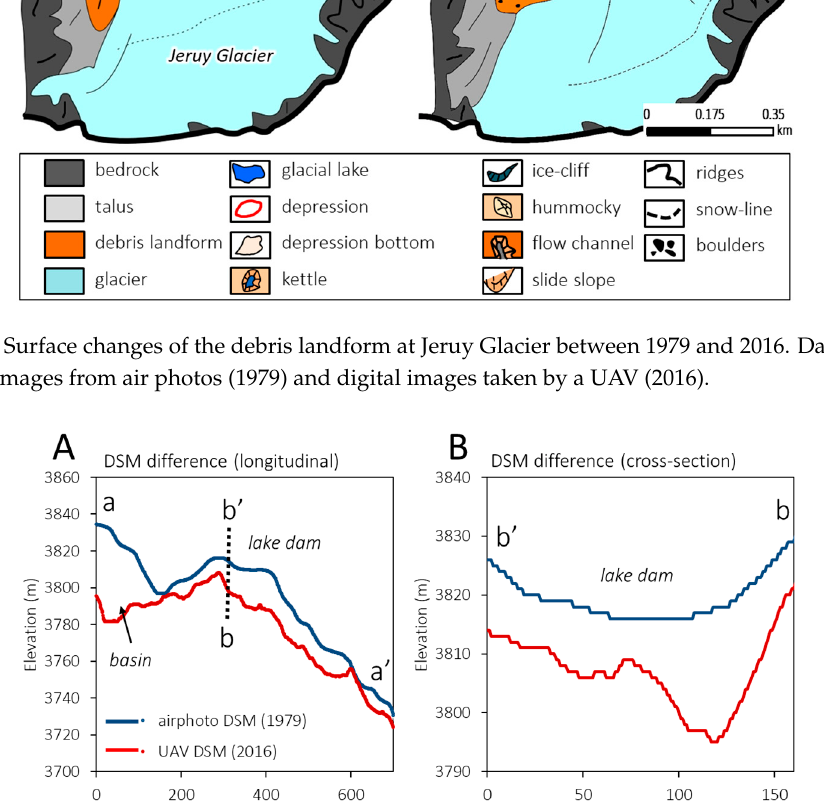
Figure 5. Elevation profiles from 1979 and 2016 of debris landforms at the Jeruy Glacier. ( A ) Longitudinal profile along a–a’ marked in the 2016 panel of Figure 4. ( B ) Transverse profile along b–b’ from the same panel. Based on DSMs generated from air photos (1979) and UAV images (2016).